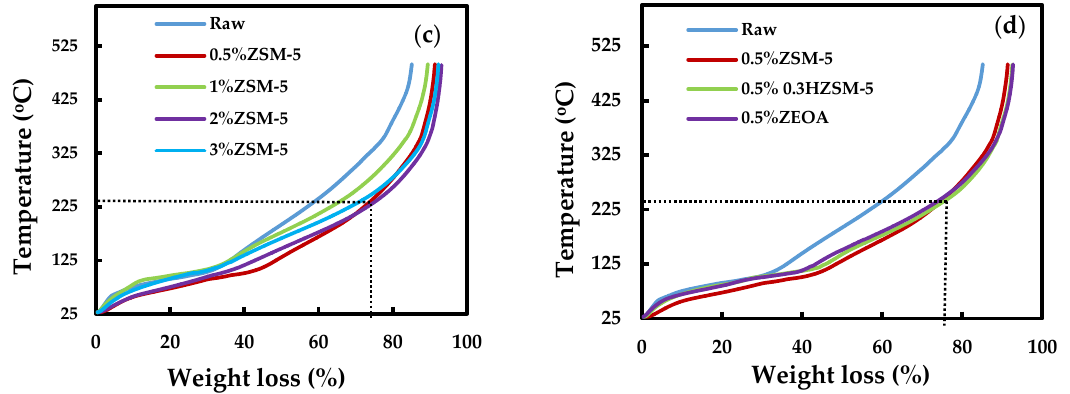
Figure 5. DTG ( a , b ) and TG ( c , d ) curves of organic bio-oil produced with and without catalysts.